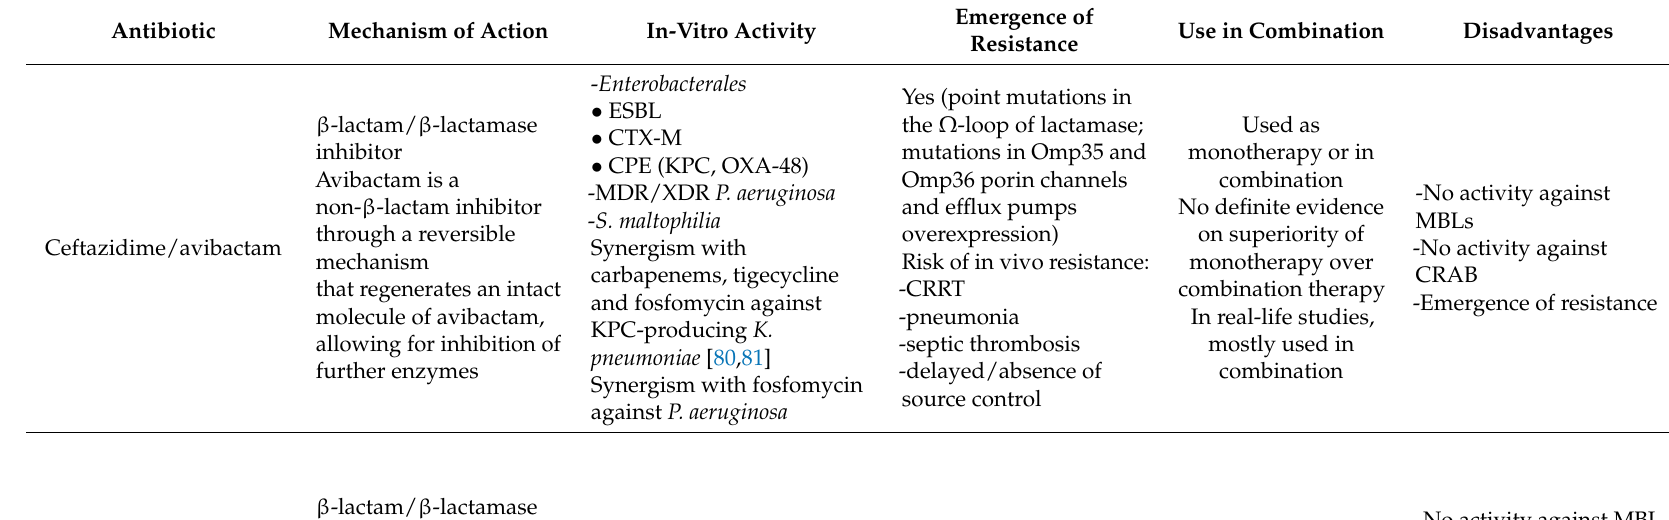
Table 1. Principal features of ceftazidime/avibactam, meropenem/vaborbactam and